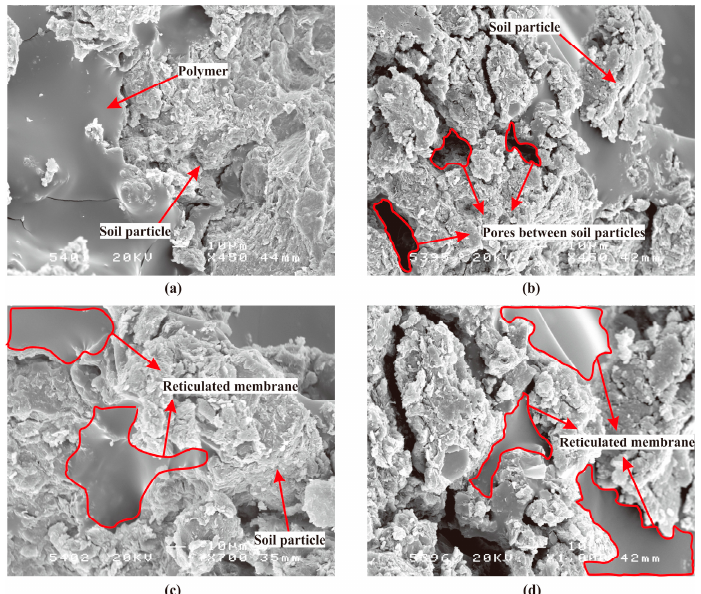
Figure 8. The scanning electron microscopy (SEM) micrographs of reinforced soil: ( a ) 450 times magnification; ( b ) 450 times magnification; ( c ) 700 times magnification; ( d ) 1000 times magnification.